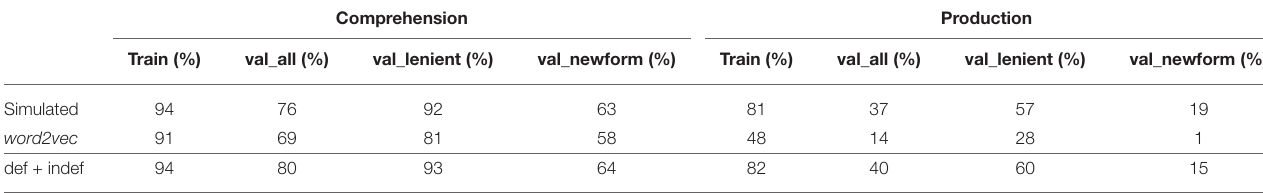
TABLE 8 | Comprehension and production accuracy for train and validation datasets with